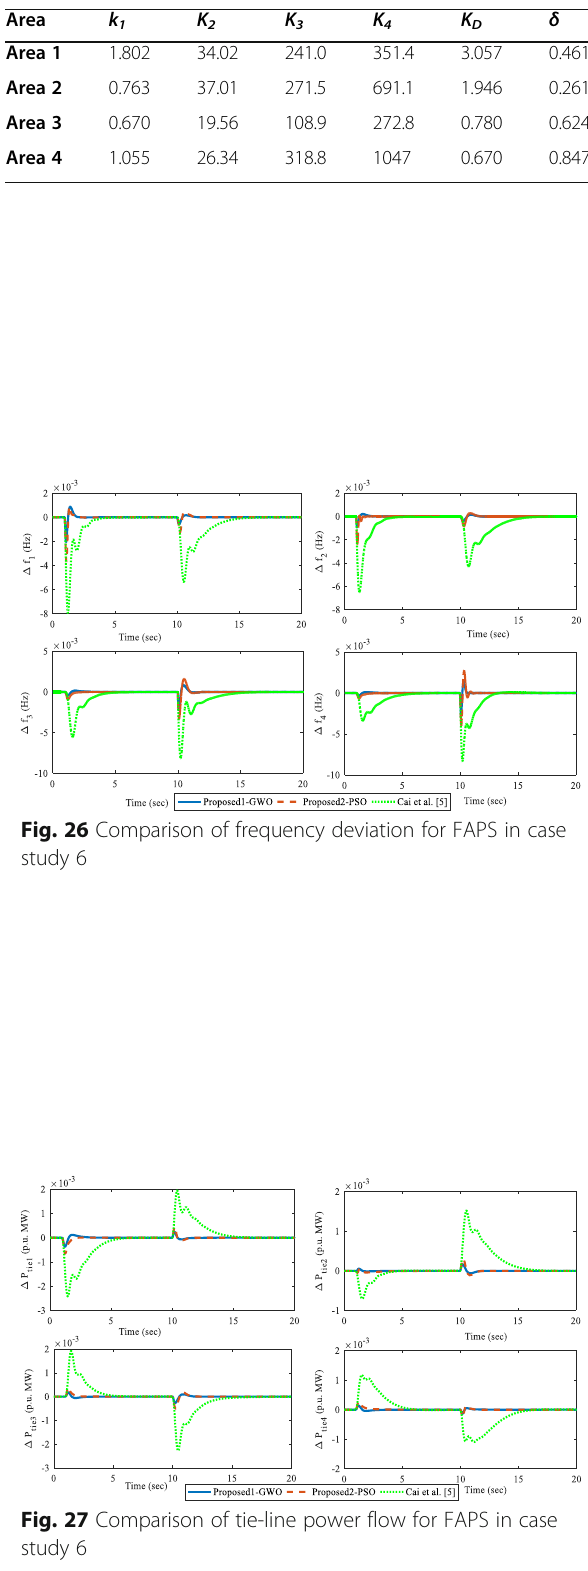
Table 7 Parameters of sliding mode controller based on PSO for FAPS